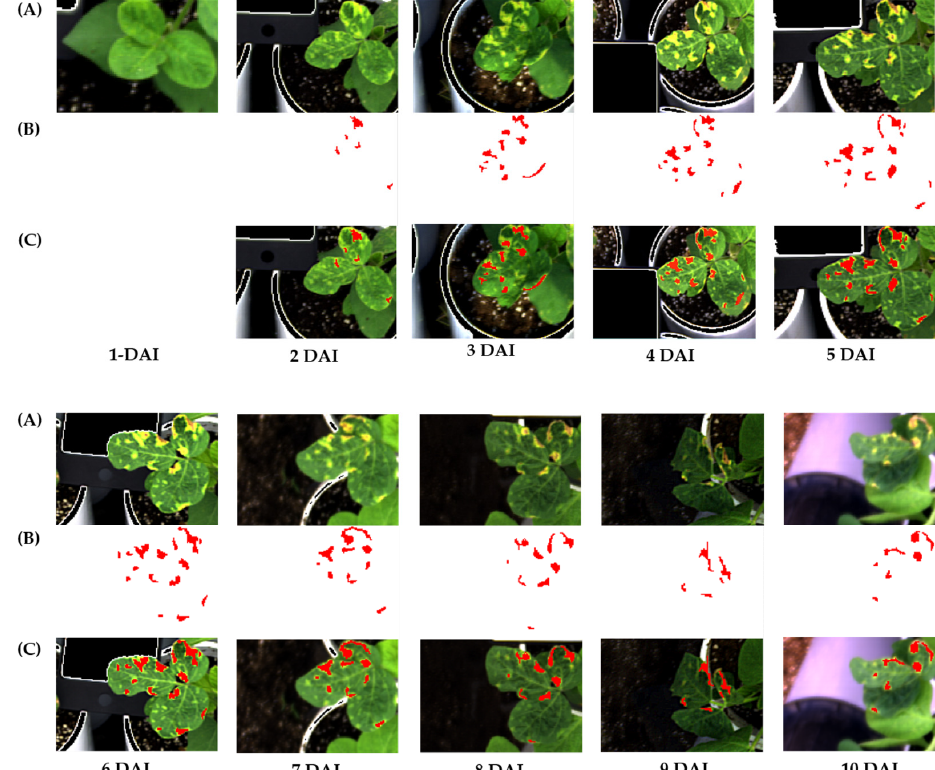
Figure 4. Annotation of the diseased region for data extraction till 10 days after inoculation. ( A ) Original image, ( B ) diseased region, annotated using ENVI software, ( C ) Merged images of the orig- inal image and ROI. Both images were almost matched; therefore, these images guaranteed that the collected hyperspectral data were exactly collected from the diseased region.